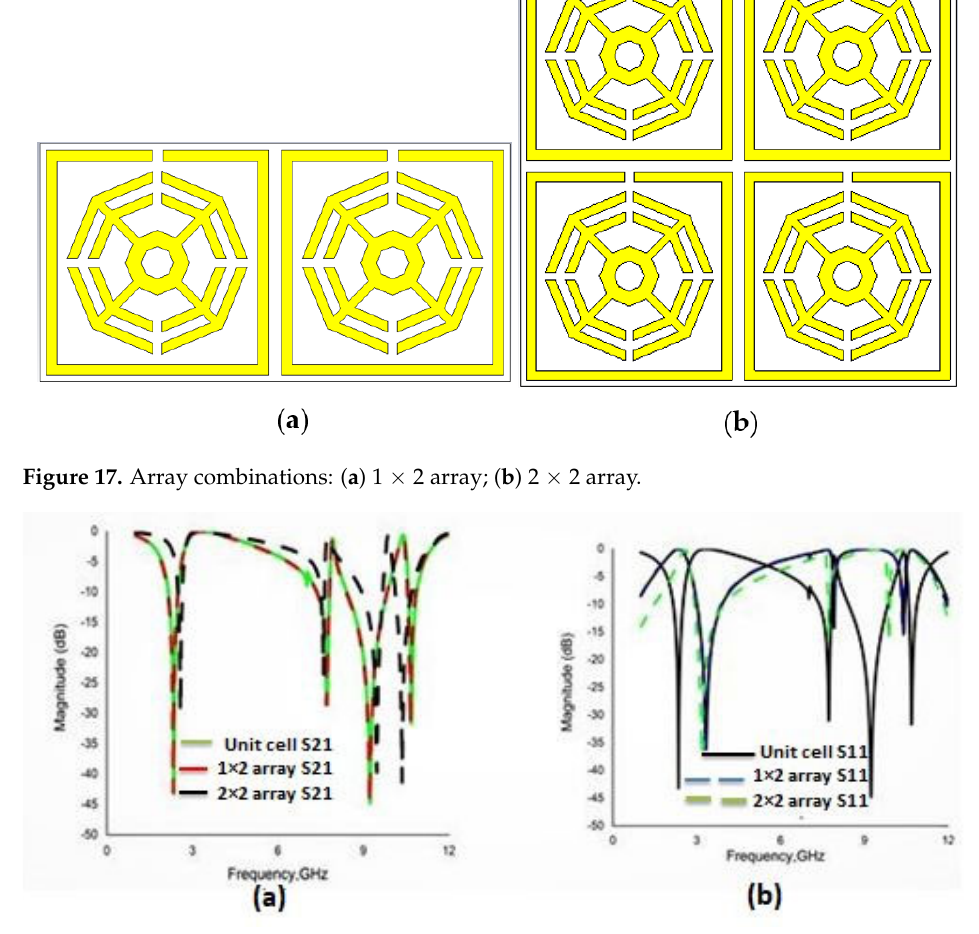
Table 4. Deviation of frequency for various arrays of unit cells.